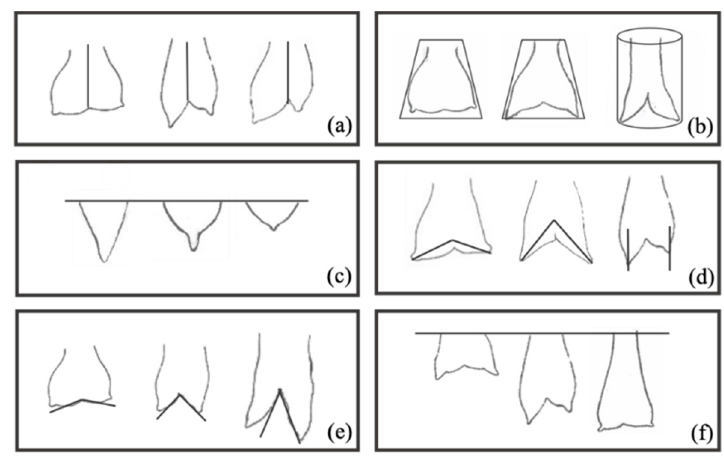
Figure 2. Morphological characterization of the sample (Serrana goats); Parameters: Symmetry ( a ), Udder shape ( b ), Teat Shape ( c ), Teat angle ( d ), Degree of separation ( e ), Degree of suspension ( f ).